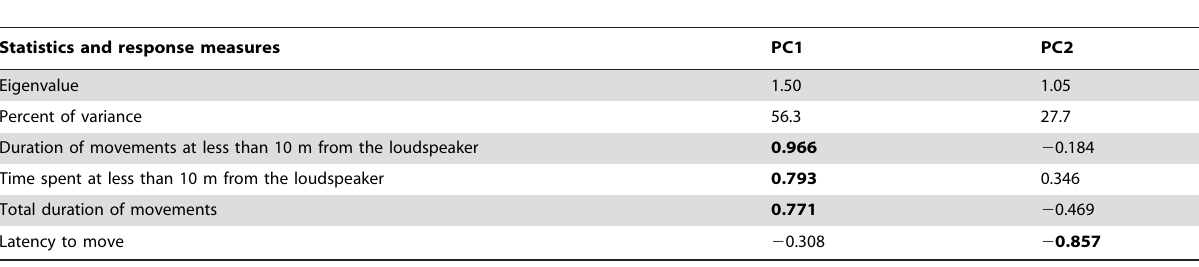
Table 1. Factor loadings of the response measures on the first two principal